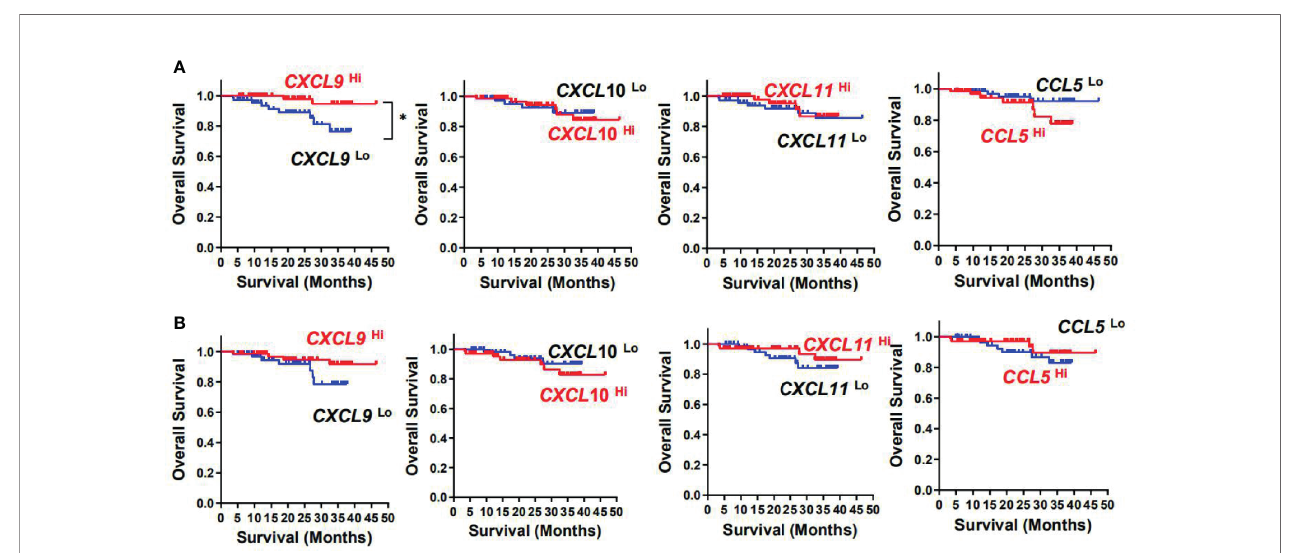
FIGURE 3 | Prognostic signi fi cance of CXCL9, CXCL10, CXCL11 , and CCL5 in CRC patients. Cumulative OS times were calculated by the Kaplan – Meier method and analyzed by the log-rank test. The patients were divided into two groups according to the median value of CXCL9, CXCL10, CXCL11 , and CCL5 in tumor (A) or adjacent normal tissues (B) .